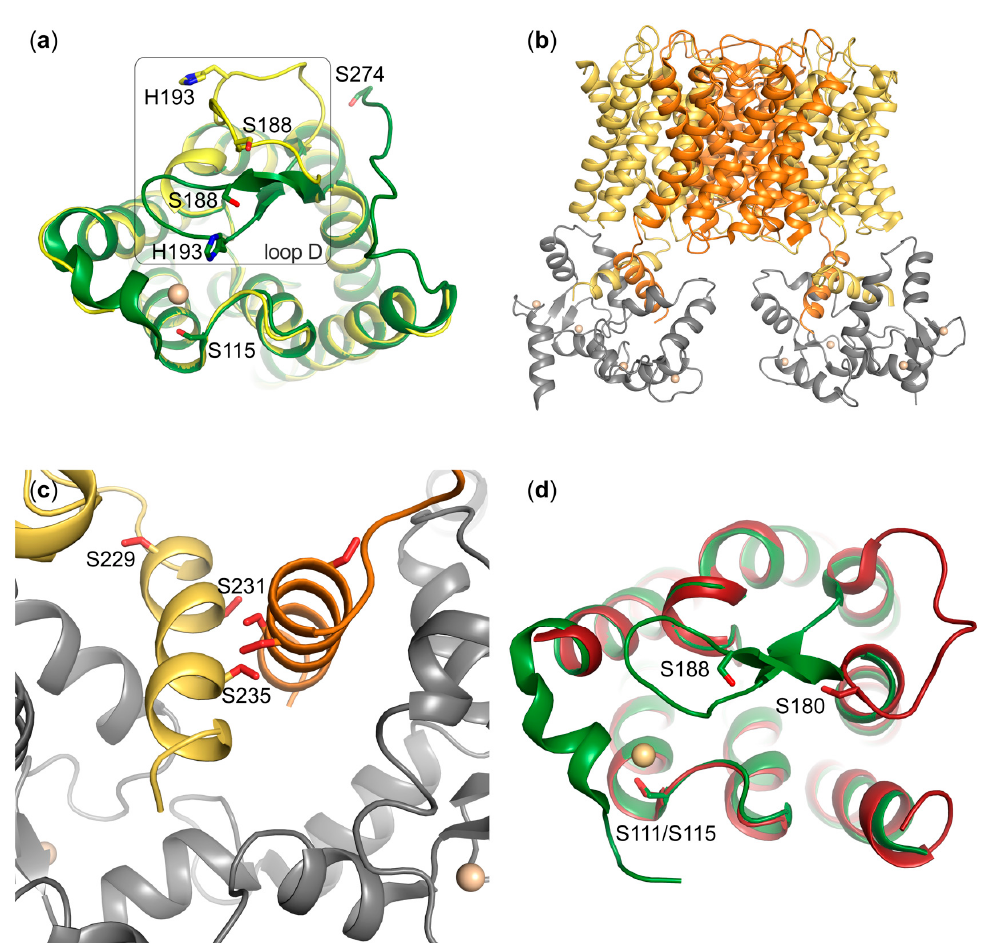
Figure 2. Structural features of aquaporin gating. ( a ) Comparison of the SoPIP2;1 crystal structures in closed (green, PDB code 1Z98) and open (yellow, PDB code 2B5F) conformations. Residues involved in gating are highlighted in stick representation. In the closed conformation, loop D is held in place by an interaction with a Cd 2+ -ion (beige), representing an in vivo Ca 2+ -site, thereby occluding the channel. Phosphorylation of S115 as well as S274 from the neighbouring monomer destabilize the closed state. ( b ) Model of the complex between AQP0 (yellow and orange) and calmodulin (grey) based on a 25Å pseudoatomic cryo-EM structure (PDB code 3J41). Two molecules of calmodulin bind to one AQP0 tetramer and this interaction results in closure of the water pore. ( c ) Zoom-in on the interaction site in the AQP0-calmodulin complex, showing how each molecule of calmodulin binds two short C-terminal helices from neighbouring AQP0 monomers. Identified phosphorylation sites in AQP0 are highlighted. The phosphorylation of these residues affects calmodulin binding and water permeability of AQP0. ( d ) Crystal structure of human AQP4 (red, PDB code 3GD8) overlaid with the closed structure of SoPIP2;1 (green). Phosphorylation sites in loop B (S111/S115) and loop D (S188 and S180) are highlighted. Loop D in AQP4 is significantly shorter than in